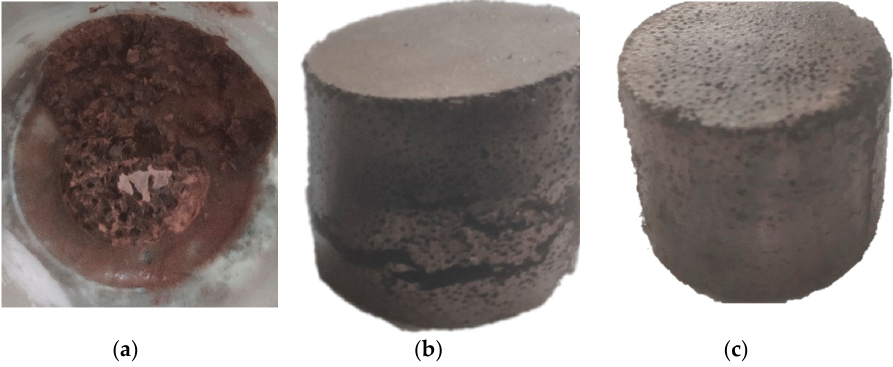
Figure 4. Water bath condition of copper foam preform, ( a ) the electrolytic copper preform, ( b ) the flake copper preform hot water bath, and the ( c ) flake copper preform cold water